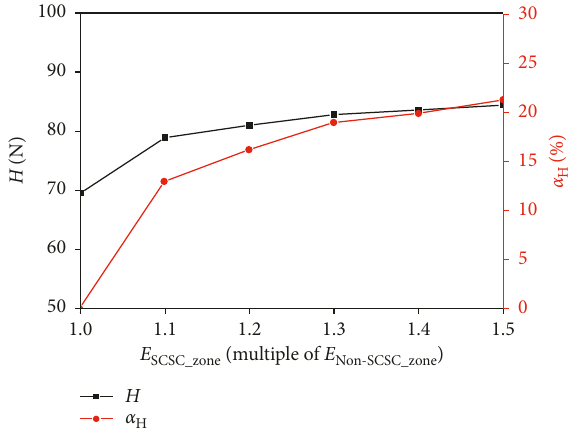
Figure 15: Effects of E SCSC_zone on the ultimate horizontal bearing capacity of the CCFSTP.